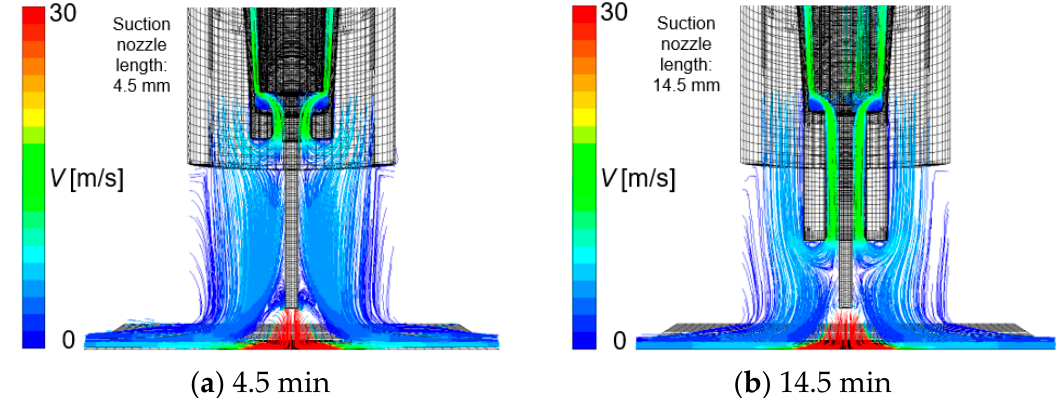
Figure 14. The effect of suction nozzle length on gas flow velocity: ( a ) 4.5 mm, ( b ) 14.5 mm.